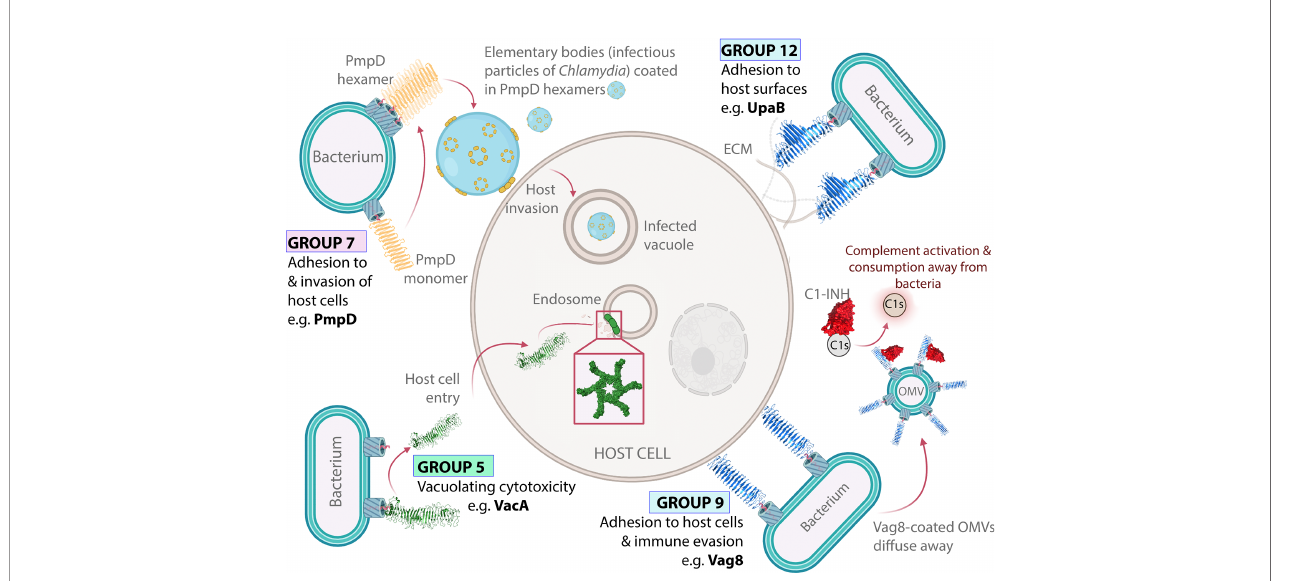
FIGURE 4 | Virulence functions of ATs from Groups 5 – 12. VacA forms oligomeric pores in intracellular host membranes. VacA (Group 5) forms oligomeric pores in host intracellular membranes including endosomes through horizontal interactions in the lipid bilayer. PmpD is an oligomeric host adhesin. PmpD (Group 7) forms oligomeric rings within the bacterial OM and facilitates host cell invasion. Oligomeric ring structures based on electron microscopy images published by Swanson, et al. (168). Vag8 displays dual immunomodulation and adhesion activities. Vag8 (Group 9) binds to and inhibits the host immune regulator C1-inhibitor (C1-INH), which perturbs the host immune response. Vag8 also promotes adhesion to host cells through an unknown binding interaction. UpaB allows uropathogenic E. coli to bind directly to the urogenital epithelia. UpaB (Group 12) binds to ECM proteins on the surface of epithelial cells, which allows bacteria to bind directly to host surfaces within the urogenital tract, thus promoting disease (70). The structures of VacA (PDB: 6NYF) (107), Vag8 (PDB: 7AKV) (106), and UpaB (PDB: 7AKV) (70) were visualized with PyMOL Molecular Graphics System (Schrödinger, LLC)